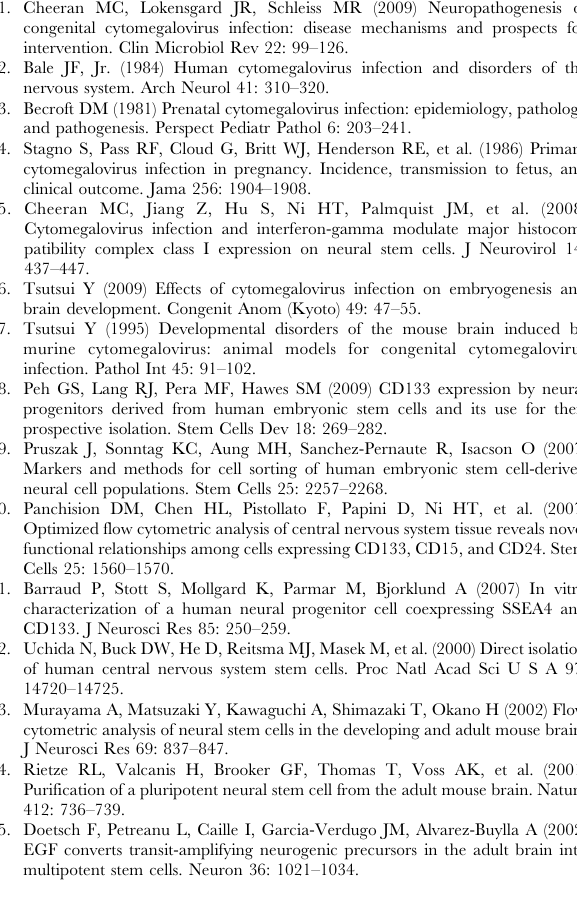
showing GFP + cells stained for nucleus (DAPI).